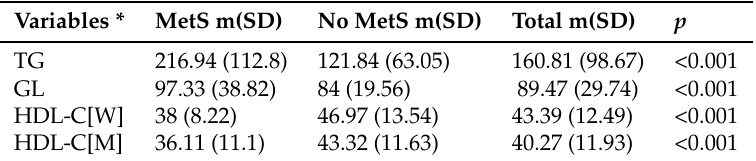
Table 7. Statistic description of the biochemical